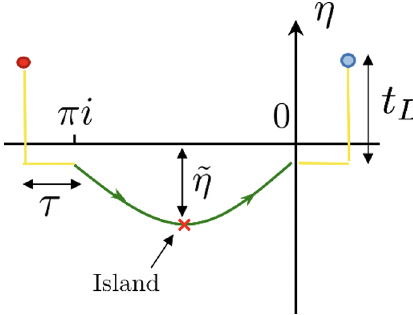
Figure 29 . (a) We highlight the Rindler structure in figure 28. The black horizontal line denotes the future boundary of the de Sitter spacetime. We consider the Hartle-Hawking vacuum on the slice Σ = Σ L ∪ Σ R that is close to the future boundary. (b) The contour that prepares the ket state on Σ . (c) When we combine (b) with the contour for the bra and trace out Σ L , we get the 2 π contour for the density matrix.